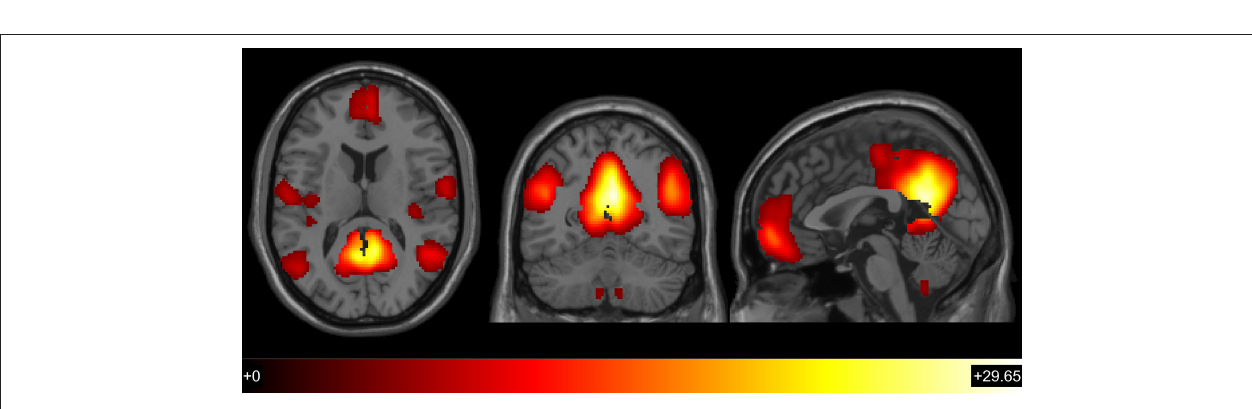
FIGURE 4 | Global patterns of default mode network functional connectivity ( t > 3.1667; p < 0.001; df =